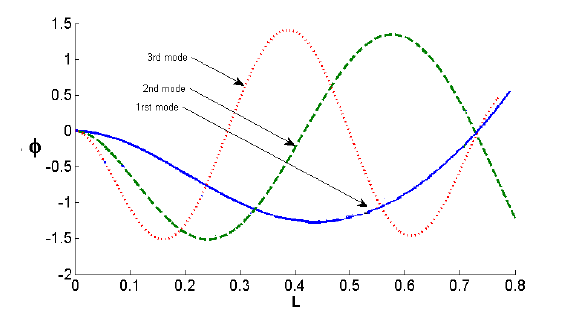
Figure 3. First three vibration modes shapes for the clamped-clamped case boundary